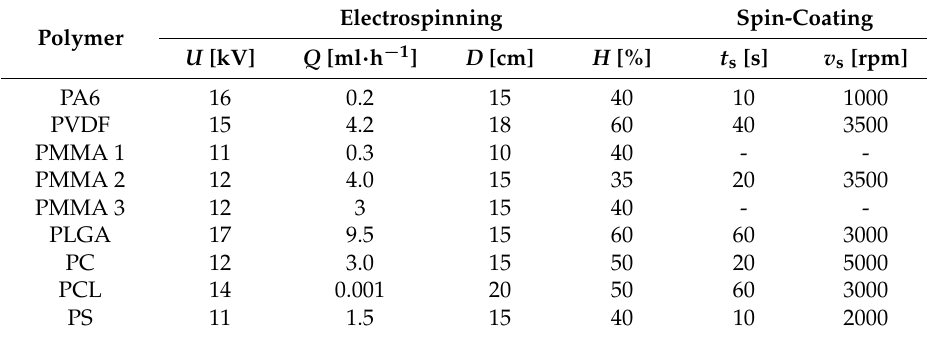
Table 2. The electrospinning and spin-coating parameters used to produce polymer fibers and films.